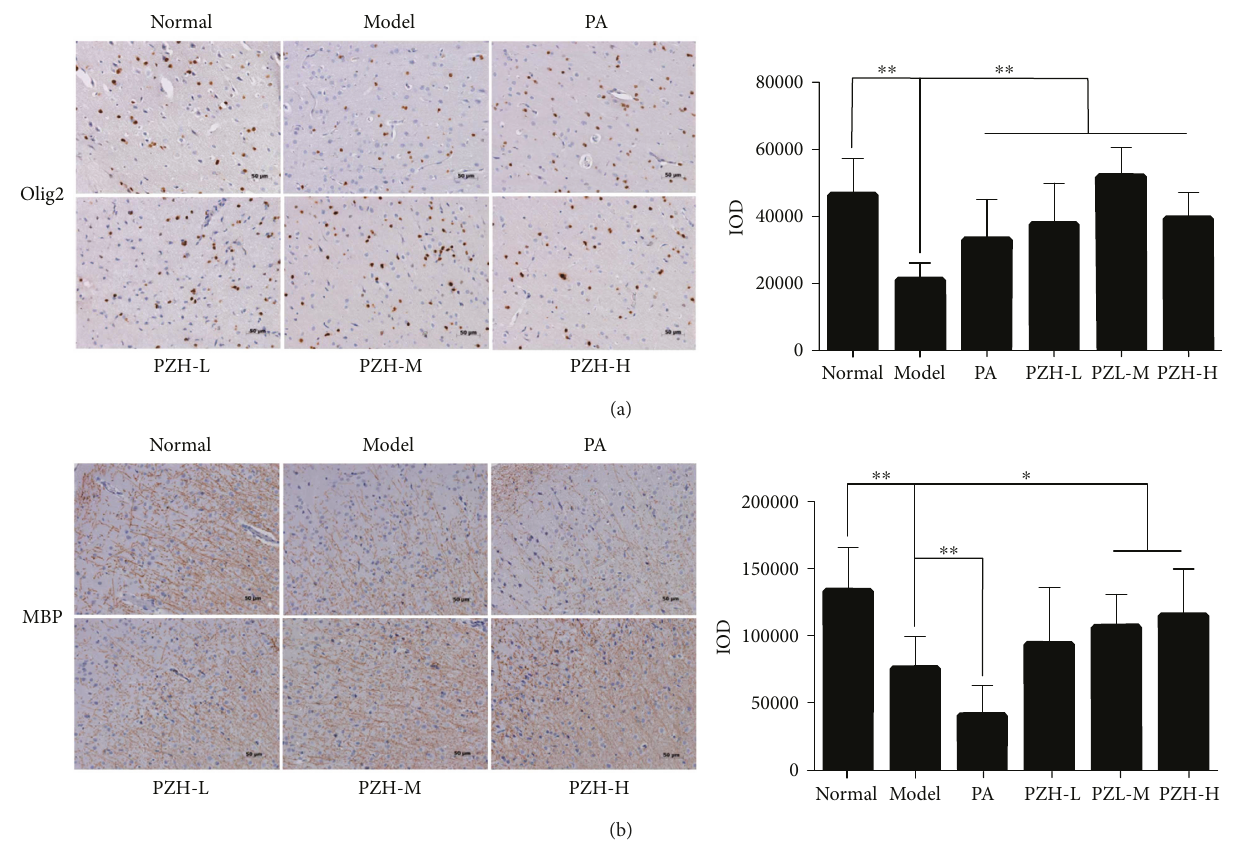
Figure 6: PZH increased the expression of Olig2 and MBP in EAE rats. Representative immunohistochemistry images (left) and IOD means (right) of Olig2 (a) and MBP (b) in the brain of rats from each group. Original magni fi cation 200x. All data were shown as the mean ± SD. ∗ P < 0 05 and ∗∗ P < 0 01